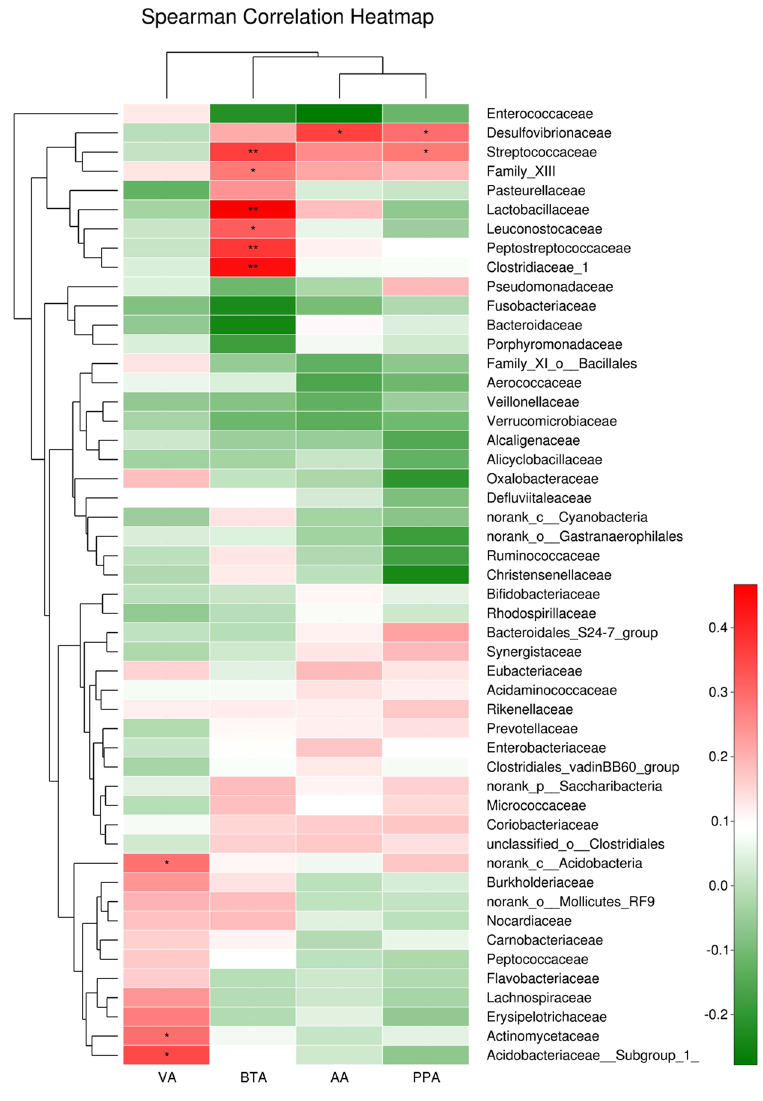
Figure 5. Correlation of the gut microbiota with the levels of fecal SCFAs. The heatmap shows the correlation coefficient between bacterial taxa and the level of fecal SCFAs at the family level. * p < 0.05; ** p <